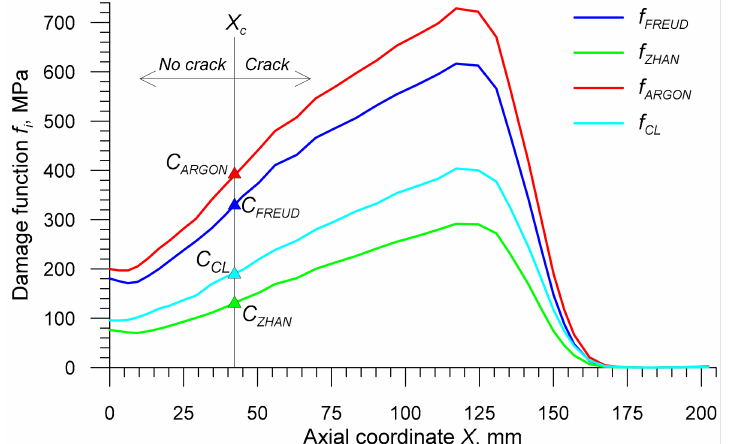
Figure 16. Stress-based damage functions in the axial zone of the specimen in the CWR test, with T 0 = 1000 ◦ C (the axial coordinate X = 0 mm denotes symmetry plane).